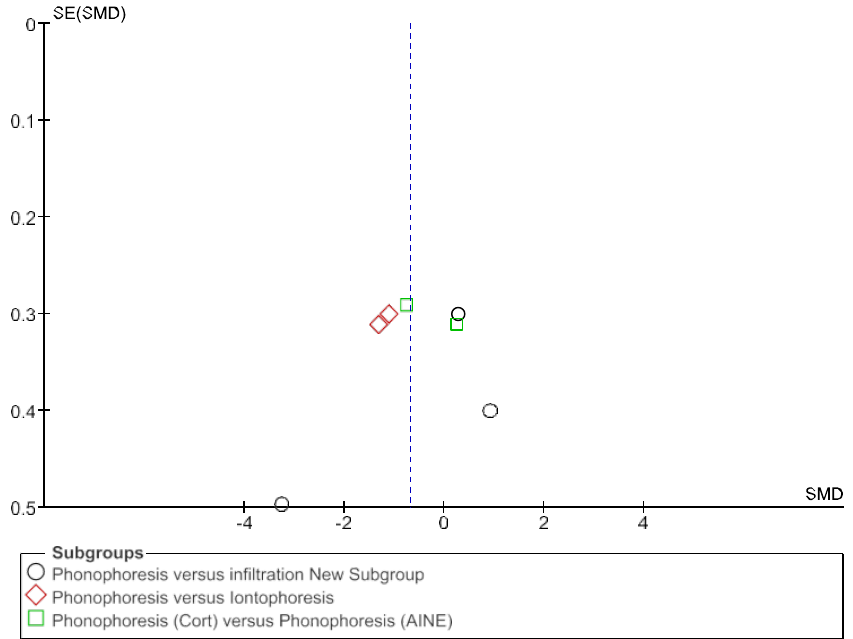
Figure 14. Phonophoresis for pain.